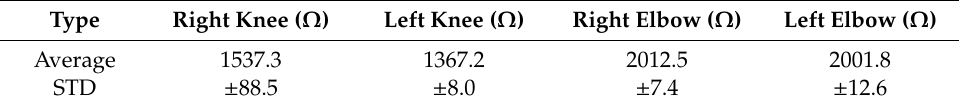
Table 1. Average and standard deviation (STD) of the knee and elbow joints (n = 242).